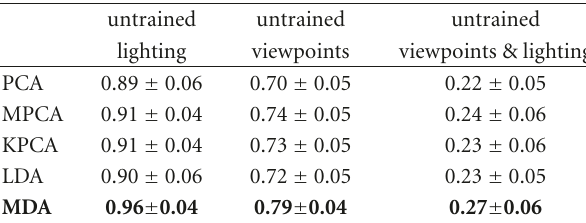
Table 2: Rank 1 recognition rate on the CMU PIE database. untrained untrained untrained lighting viewpoints viewpoints & lighting PCA 0.89 ± 0.06 0.70 ±